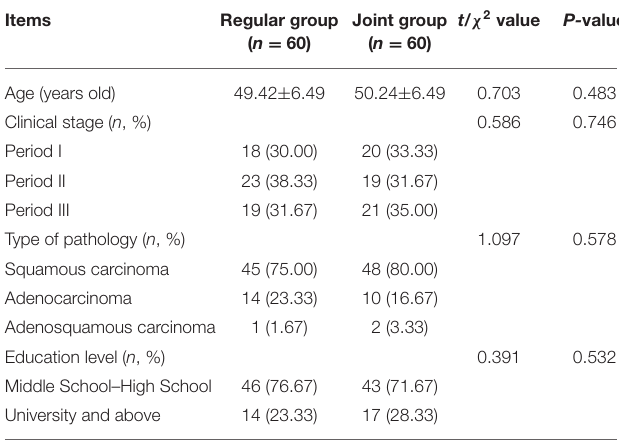
TABLE 1 | Comparison of baseline information between the two groups ( n , x ± s, %).